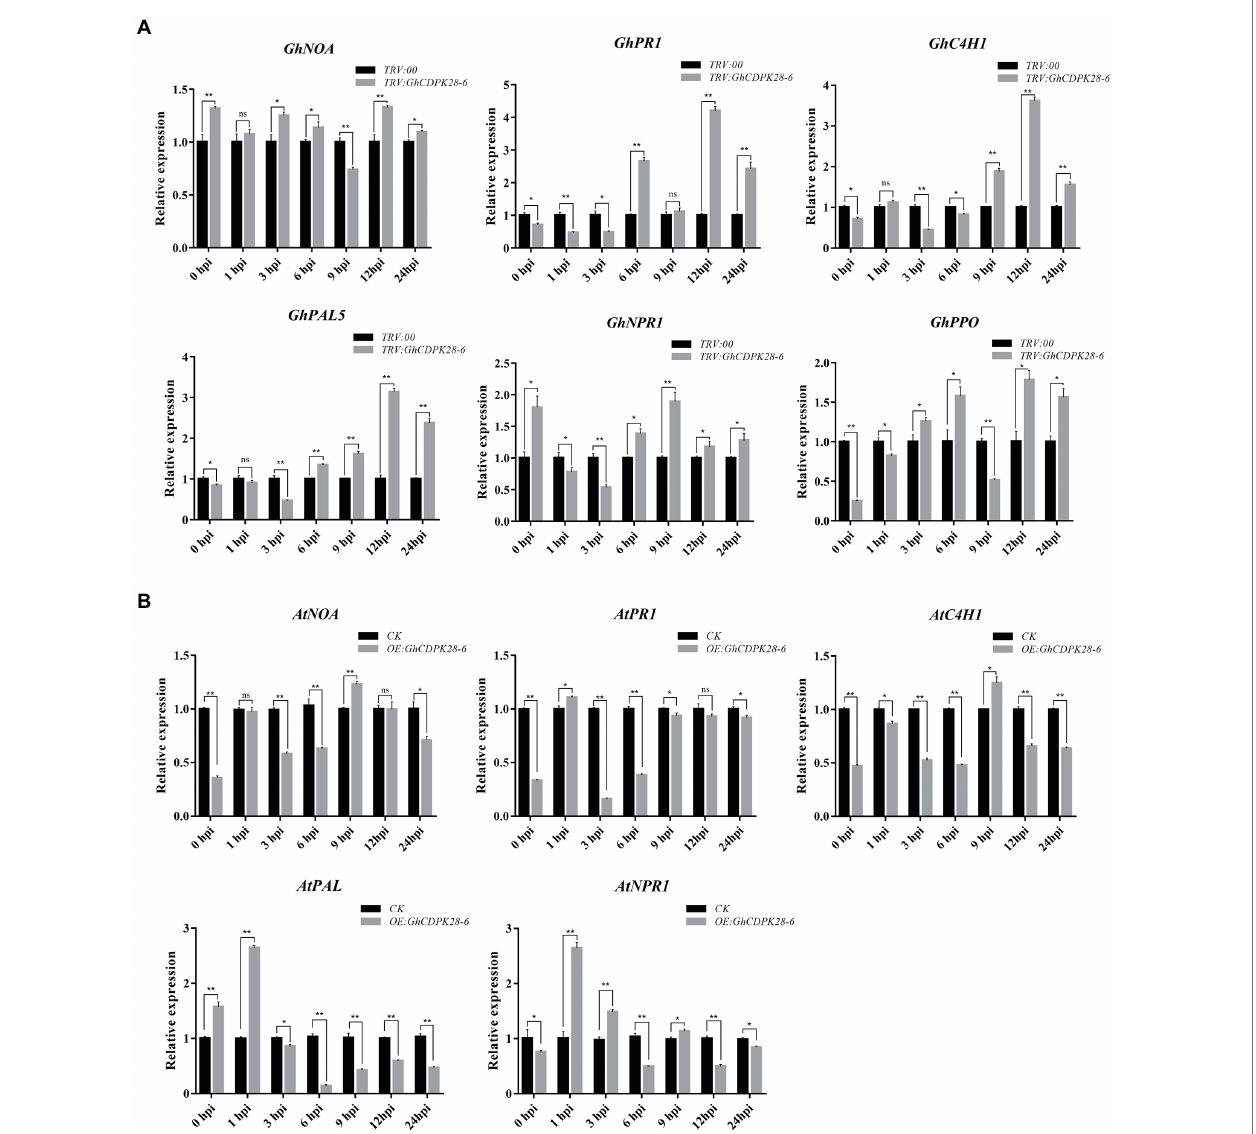
FIGURE 6 | Expression of disease-resistance related genes in silenced cotton and transgenic Arabidopsis . (A) RT-qPCR analysis of six disease-resistance related genes in leaves of cotton. The GhUBQ7 gene was used as the reference gene. (B) RT-qPCR analysis of five disease-resistance related genes in leaves of Arabidopsis . AtUBQ10 as the internal control gene. The error bar represents standard deviation of three biological replicates. Asterisks indicate statistically significant differences (* p < 0.05; ** p < 0.001, Student’s t